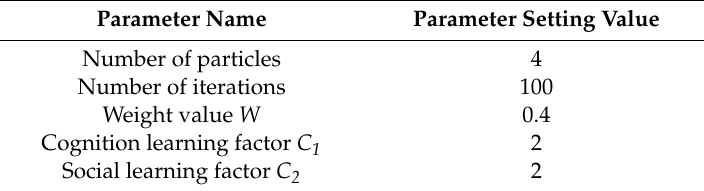
Table 2. Parameter setting value of improved PSO proposed in Reference [21] and that proposed in this study.